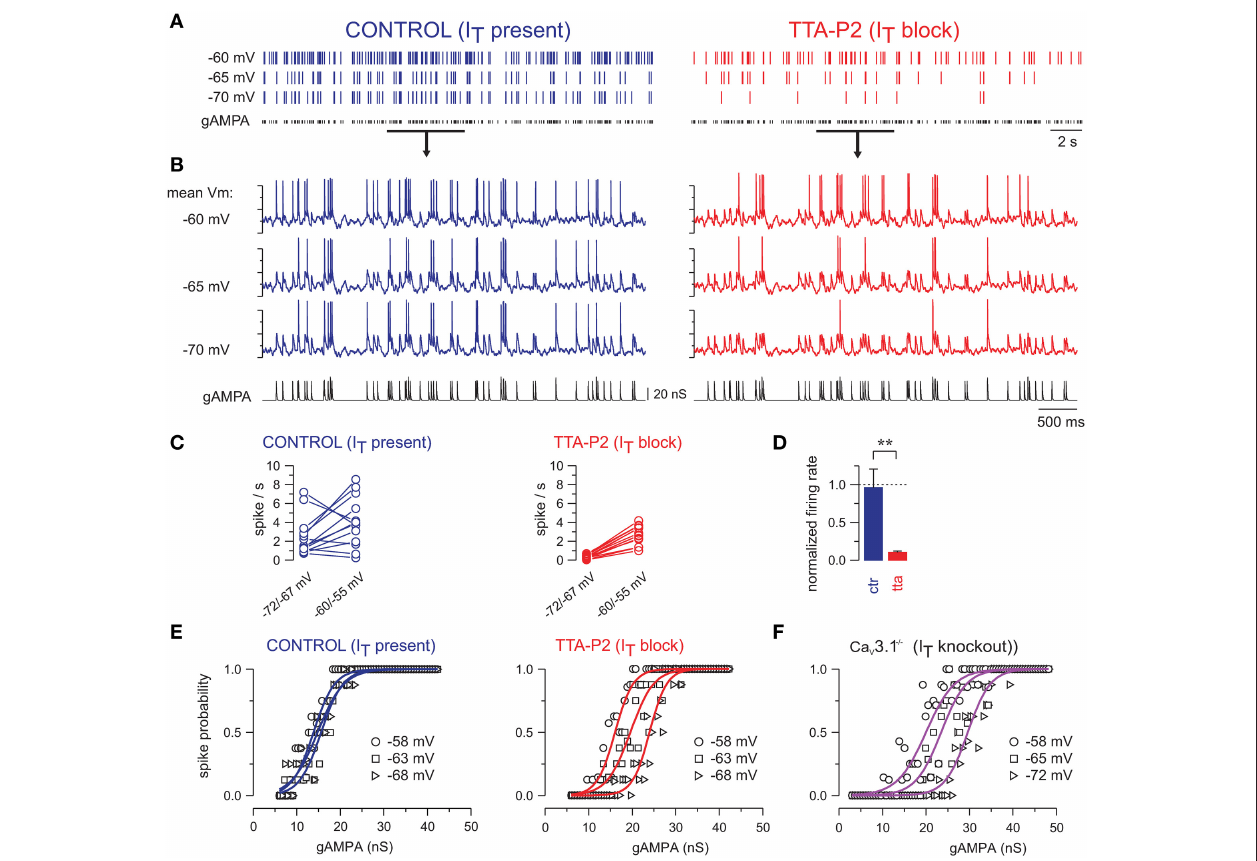
FIGURE 4 | T-current provides robustness to the response of TC neurons across a large range of membrane potentials. (A) Spike raster plots of a TC neuron injected with gAMPA of fixed amplitude following a Poisson-distribution (mean frequency: 10Hz), while the mean membrane potential was successively maintained at − 60, − 65, and − 70mV. (B) Intracellular activities recorded during the time windows indicated by the black line in (A) . In control condition the firing of the neuron remained almost invariant across the entire voltage range, but strongly decreased upon hyperpolarization when T-current was blocked. (C) Firing frequencies calculated in each neuron successively maintained at a membrane potential between − 60/ − 55mV and between − 72/ − 67mV while being submitted to the same gAMPA/noise sequences. Hyperpolarization induced either a decrease or an increase in firing frequency in control condition (CTR; n = 13 ) but a systematic decrease in the presence of TTA-P2 (TTA; n = 14 ). (D) In each neuron, the firing frequency at hyperpolarized potentials was normalized to the one at − 60/ − 55mV. Comparison of the mean values obtained with (CTR) and without T-current (TTA; ** p < 0.01 ; independent t -test) suggests that at the level of the TC neuronal population, T-channels rescued the voltage dependent decrease in firing induced by hyperpolarization. (E) Transfer functions were quasi-invariant in the presence of the T-current but drastically shifted toward larger gAMPA values upon hyperpolarization when the T-current was blocked. (F) Similar voltage dependence of the transfer functions was observed in TC neurons recorded in Cav3.1-/- knock-out mice devoid of T-current. (E,F) are from Deleuze et al.